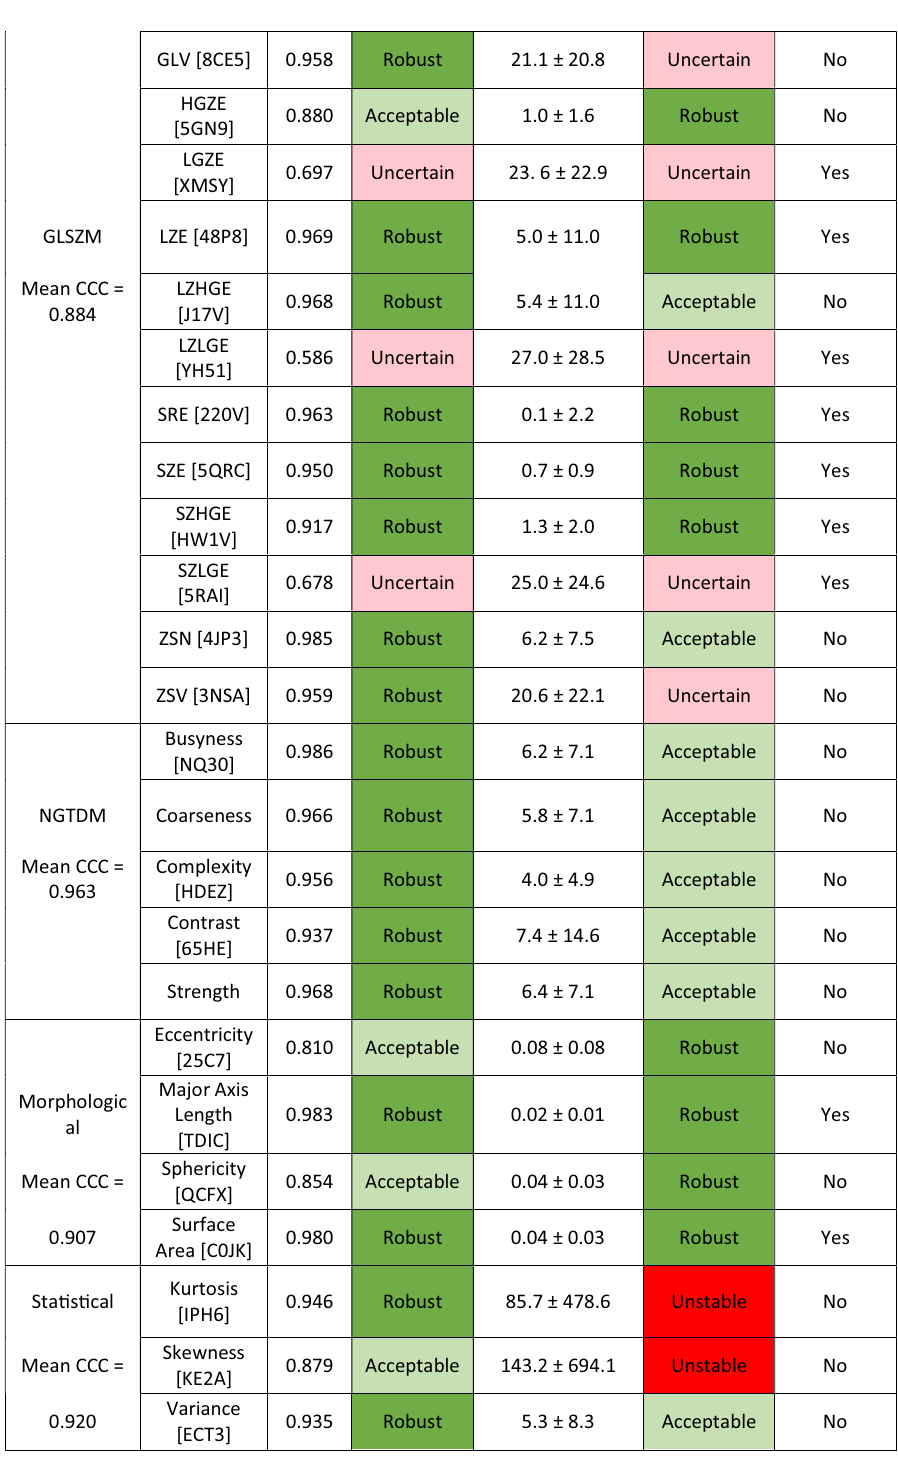
Table 2. Lin’s concordance correlation coefficient (CCC) and mean absolute percent difference in radiomic feature derived data (|%∆|RF) between auto and manual contours for all radiomic features. Corresponding stability classifications were given according to each independently and compared for consistency. CCC values classified as robust CCC > 0.90, acceptable with 0.75 < CCC < 0.90, and uncertain with CCC < 0.75. Radiomic features were classified according to mean absolute percent difference in radiomic feature derived data (|%∆|RF) as robust with mean |%∆|RF < 5%, acceptable with 5% < mean |%∆|RF < 15%, and uncertain with 15% < mean |%∆|RF <